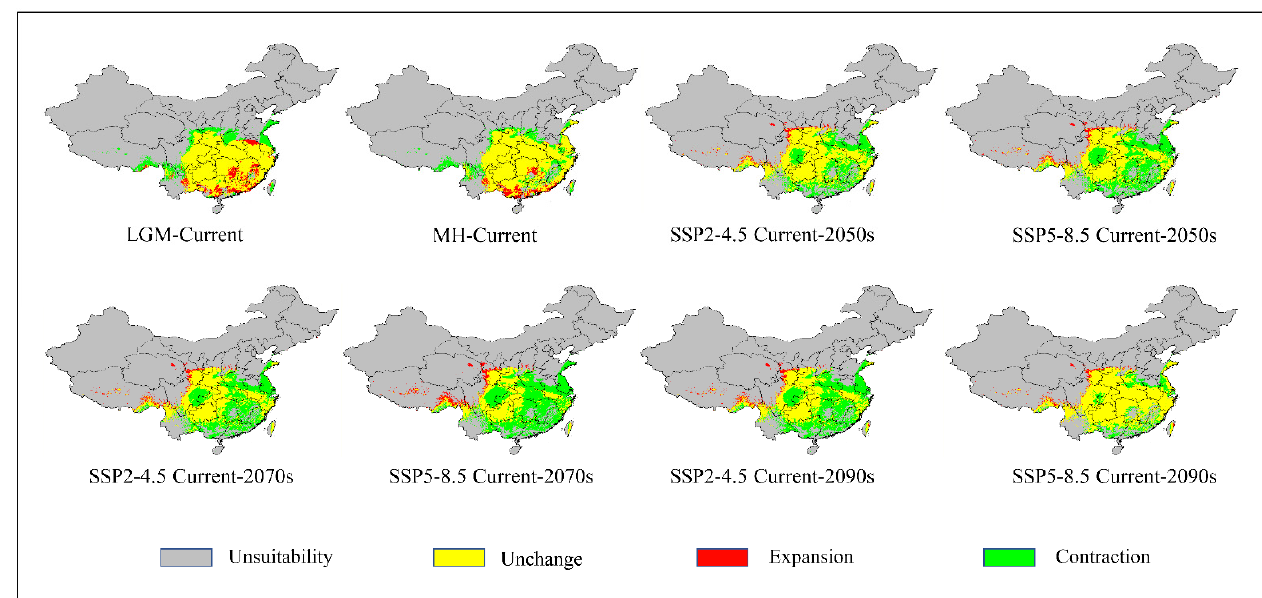
Figure 3. Predicted distribution of C. appendiculata in China under past (LGM and MH) and future (2050s–2090s) climate scenarios.